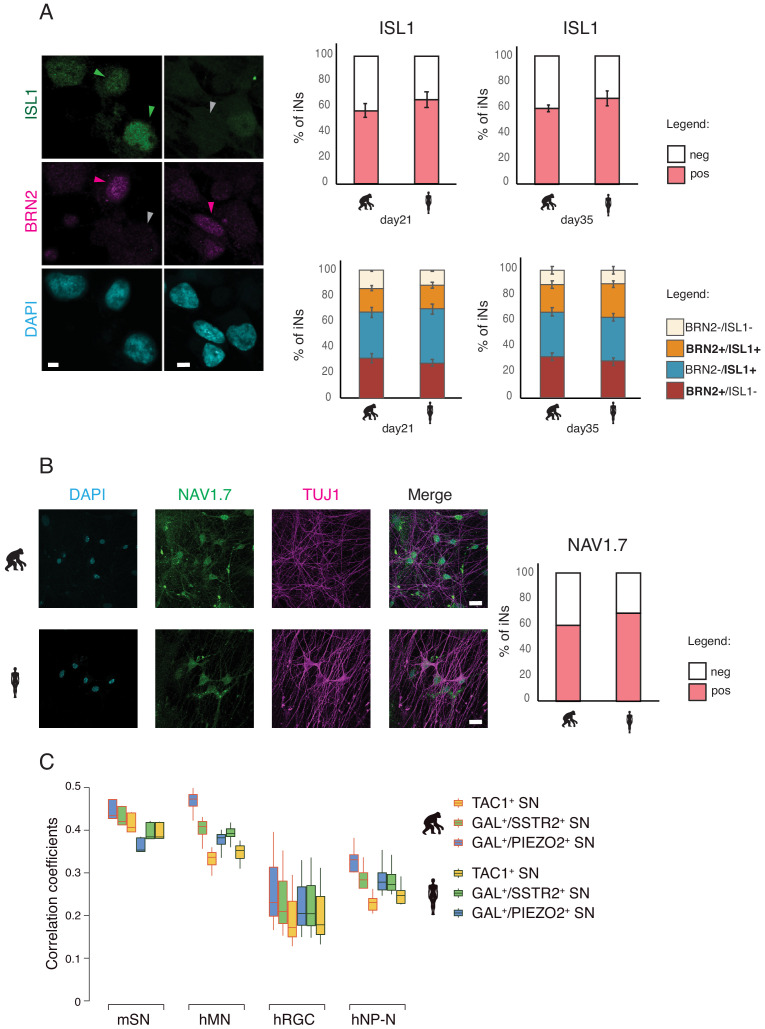
Sensory identity of iNs.The sensory fate was assessed by immunostaining for the sensory neuron proteins ISLET1 and NAV1.7. (A) 60% of the iNs were positive for ISLET1 (green) at d21 and d35 of differentiation. A proportion of iNs co-expressed BRN2 (magenta) and ISLET1 (green) protein. (C) 60–65% of iNs were immune-positive for NAV1.7 protein at d21 of differentiation. A Tukey's post hoc test revealed no significant pairwise differences between the species (see Supplementary file 6).